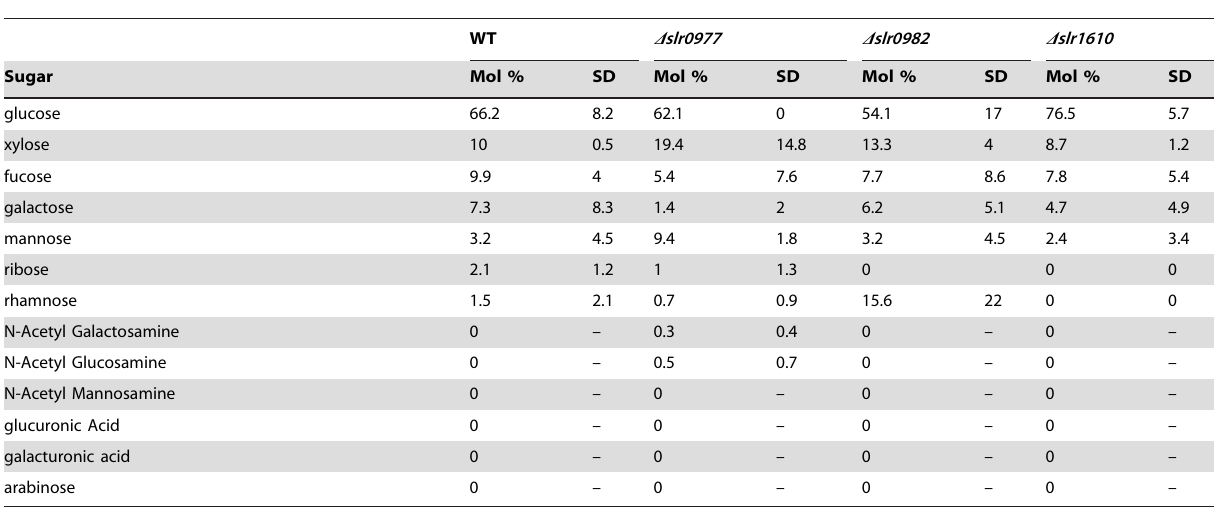
Table 4. Gas chromatographic analysis of OAg components a .